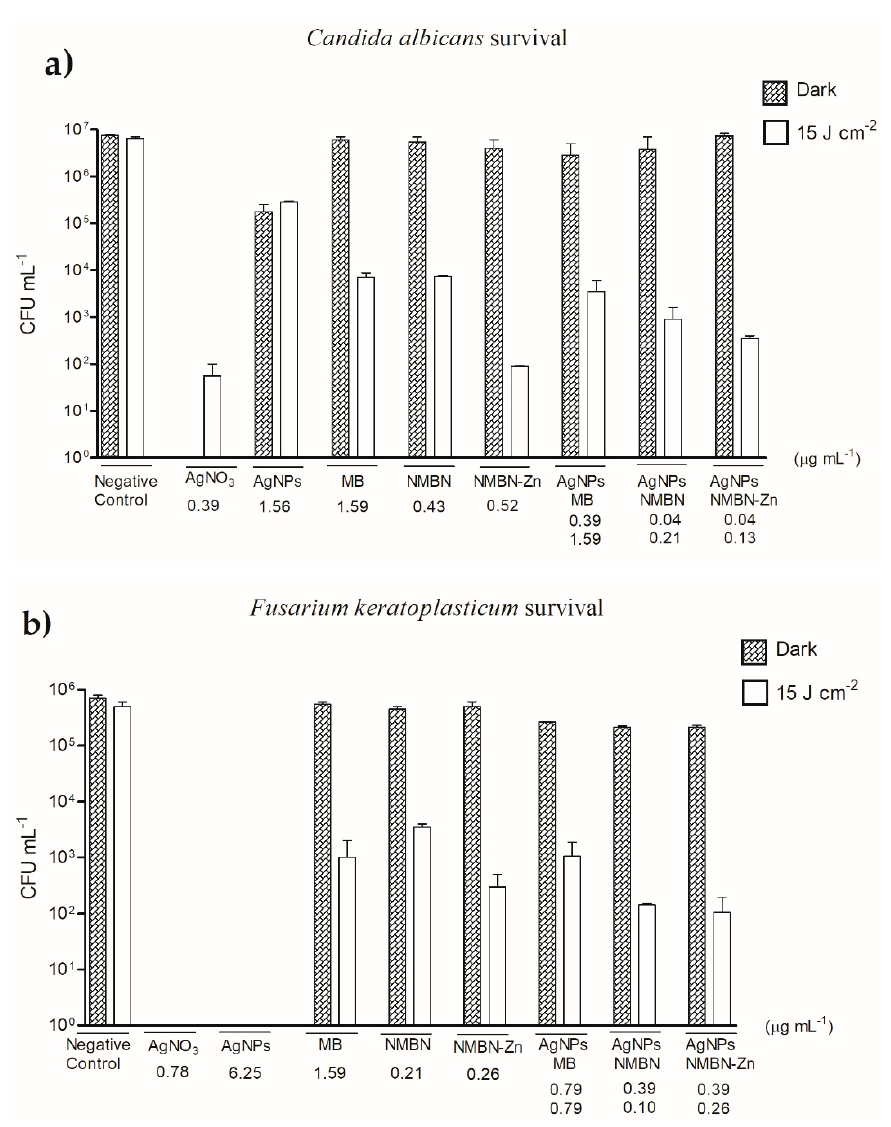
Figure 4. Antifungal survival test. The effect of APDT with the radiant exposure of 15 J cm − 2 on the survival of the yeasts of C. albicans ( a ) and filamentous fungus F. keratoplasticum. ( b ) The concentrations of the compounds are shown in Tables 1 and 2. Error bars are the standard deviation of three independent experiments. CFU, colony-forming units; Negative control, dark and red light (15 J cm − 2 ); AgNO 3 , silver nitrate; AgNPs, silver nanoparticles; MB, methylene blue; NMBN, new methylene blue N; NMBN-Zn, new methylene blue N Zinc.